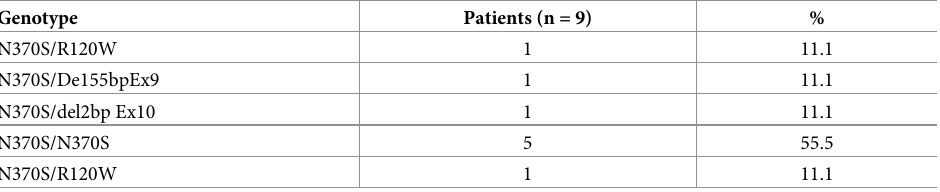
Table 1. Genotype frequency in patients with GD Type I.